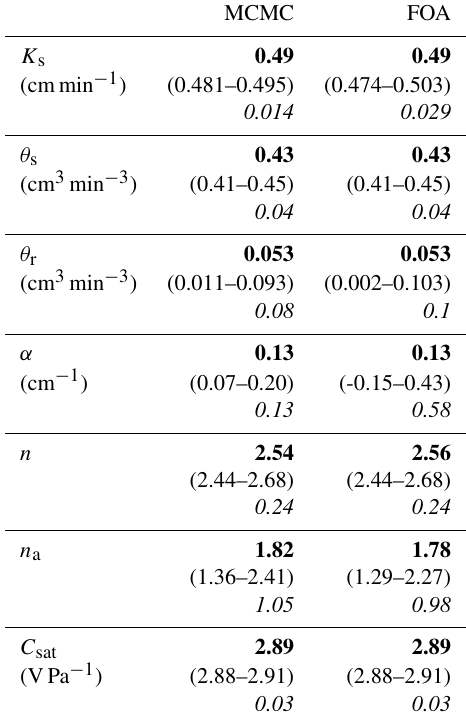
Table 4. Estimated mean values (bold), confidence intervals (CIs) and size of the posterior CIs (italic) with MCMC and FOA ap- proaches for scenario